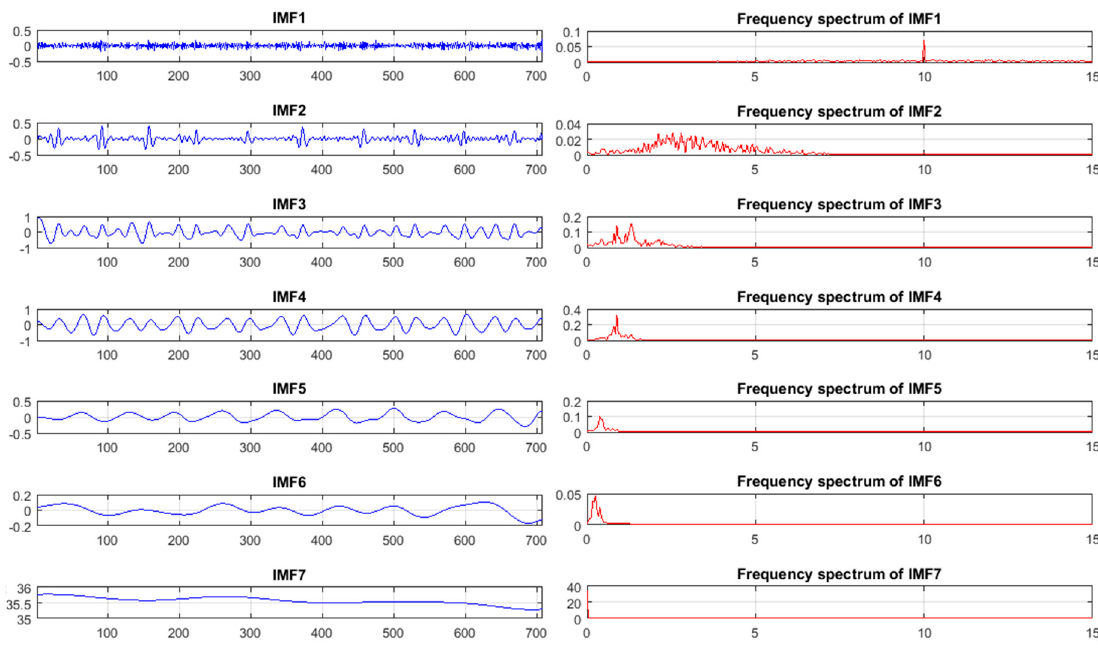
Figure 4. Intrinsic mode function (IMF) components of the improved complete ensemble empirical mode decomposition (CEEMD) technique with noise adaptation and their frequency spectrums.